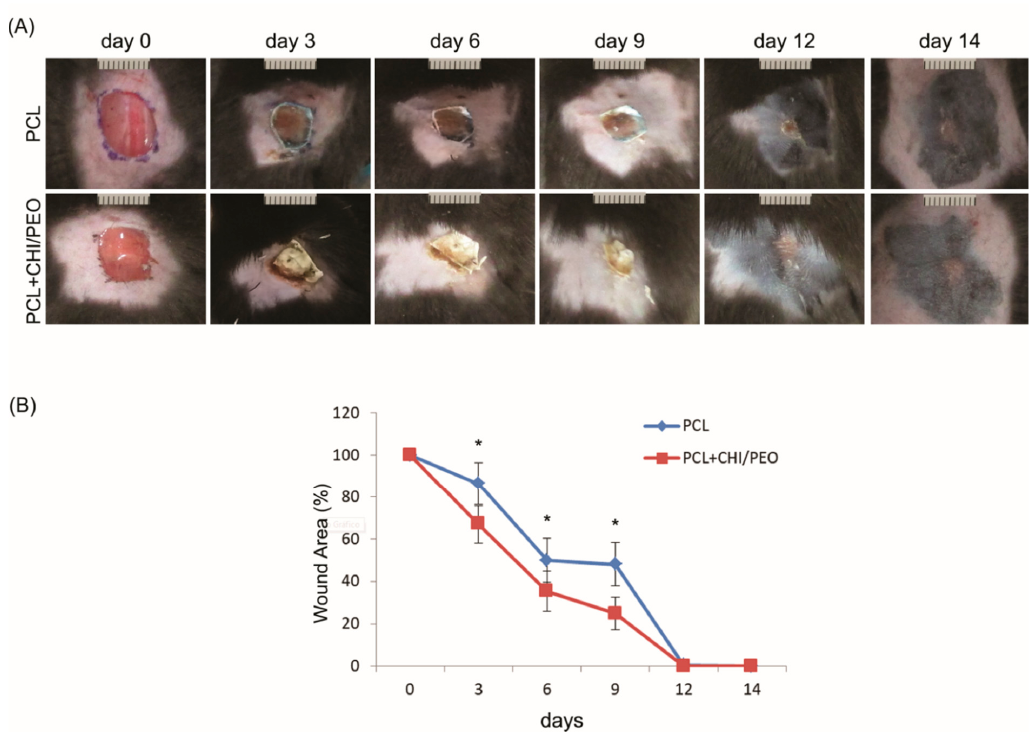
Figure 2 . ( A ) Macroscopic appearance of the lesions immediately after the surgical procedure and on the 3, 6, 9th, 12th, and 14th days after contact with the membranes. ( B ) Areas of lesion measured with ImageJ ® expressed as a percentage in the same periods mentioned above. The results were expressed as mean ± standard deviation. * p < 0.05 indicates statistically significant differences between treatments according to the Student’s t-test; ( n = 8).